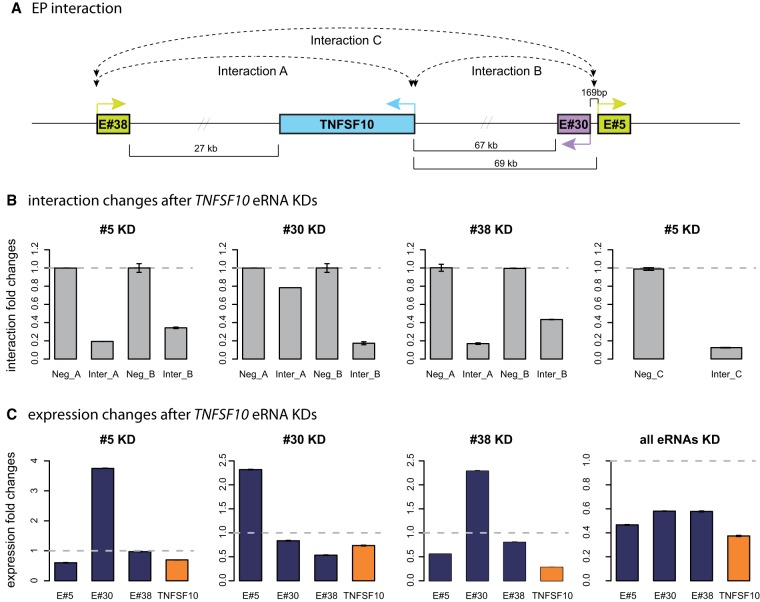
Effects of multiple enhancers on target gene expression and chromosomal conformation. (A) Schematic diagram of TNFSF10 gene with its multiple enhancers. TNFSF10 has #38 enhancer 27 kb upstream, and #30 and #5 enhancers 67 and 69 kb downstream, respectively. Colored arrows from the gene and enhancer indicate transcriptional direction. Dashed lines show physical interaction between promoter and enhancer (Interaction A and B) or between different enhancers (Interaction C). (B) Interaction changes between enhancer and promoter regions (Interaction A and B) after individual eRNA KD and all three combined eRNA KD. (C) Three eRNAs (dark blue) and target gene (orange) expression fold changes after each individual eRNA KD and after all three eRNA KD by combining three corresponding siRNAs.